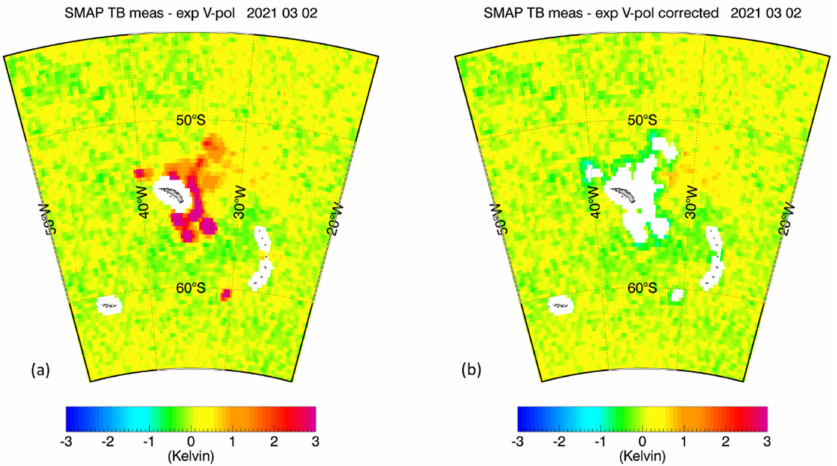
Figure 11. SMAP V-pol TB biases for an area around the South Georgia Islands near the Antarctica on 02 March 2021 (Set 9 from Table 1) that was affected by the very large drifting iceberg A-68 [35]. ( a ) before flagging and correction; ( b ) after flagging and correction showing zones